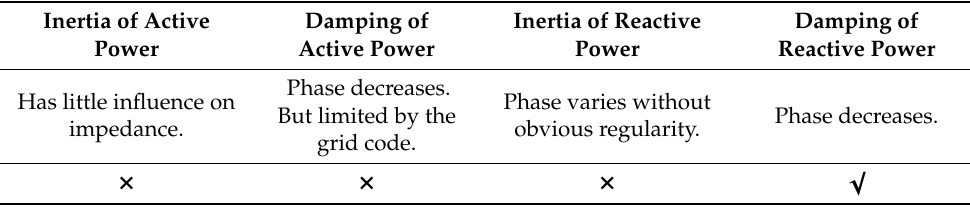
Table 1. Influence of VSG Parameters Increasing.